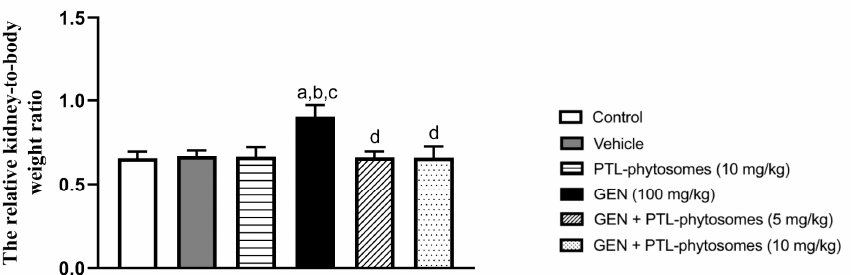
Figure 2. PTL-phytosomes treatment improved the relative kidney-to-body weight ratio. Data are expressed as Mean ± SD ( n = 6). a: significant when compared to control at p < 0.05; b: significant when compared to vehicle at p < 0.05; c: significant when compared to PTL-phytosomes at p < 0.05; d: significant when compared to (GEN)- alone at p < 0.05.